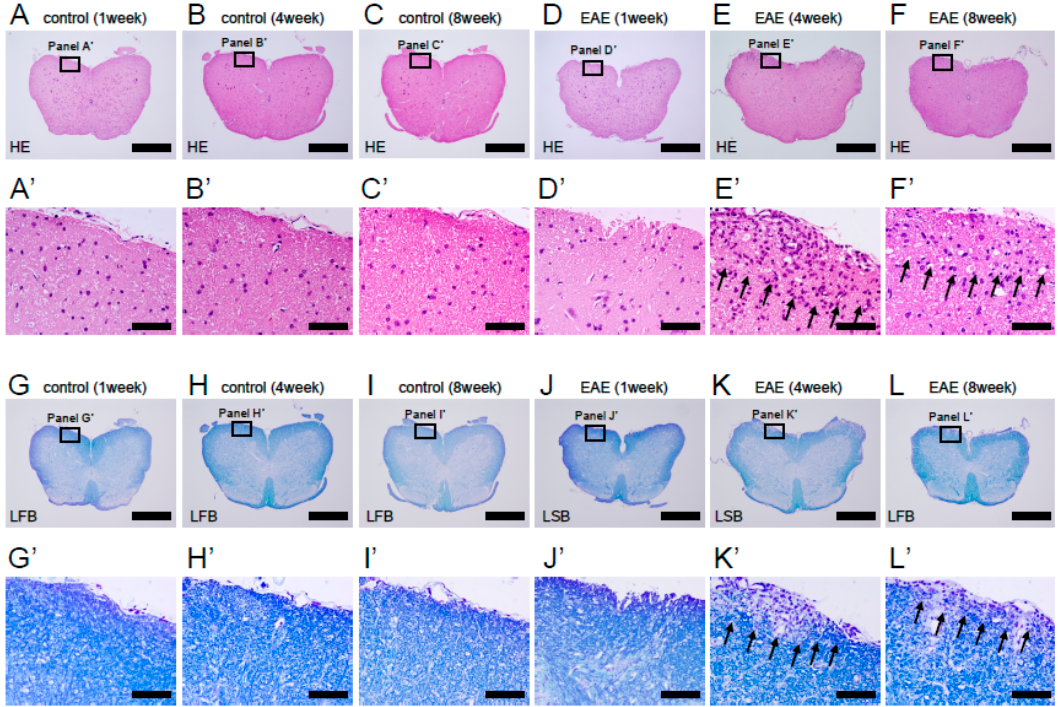
Figure 2. H&E ( A – F, A’ – F’ ) and LFB staining ( G–L, G’–L’ ) of lumbar spinal cord sections obtained from control ( A – C, A’ – C’, G – I, and G ’– I ’) and MOG-immunized mice ( D – F , D ’– F ’, J – L , and J ’– L ’) at 1, 4, and 8 weeks after treatment. Infiltration of inflammatory cells and significant demyelination was observed 4 and 8 weeks after treatment in EAE mice, whereas no demyelination was observed at any time points in control mice. Results displayed are representative of three replicates ( N = 3). Scale bars = 500 μ m ( A – L ) and 50 μ m ( A’ – L’ ). Abbreviations: H&E, hematoxylin and eosin; LFB, luxol fast blue;